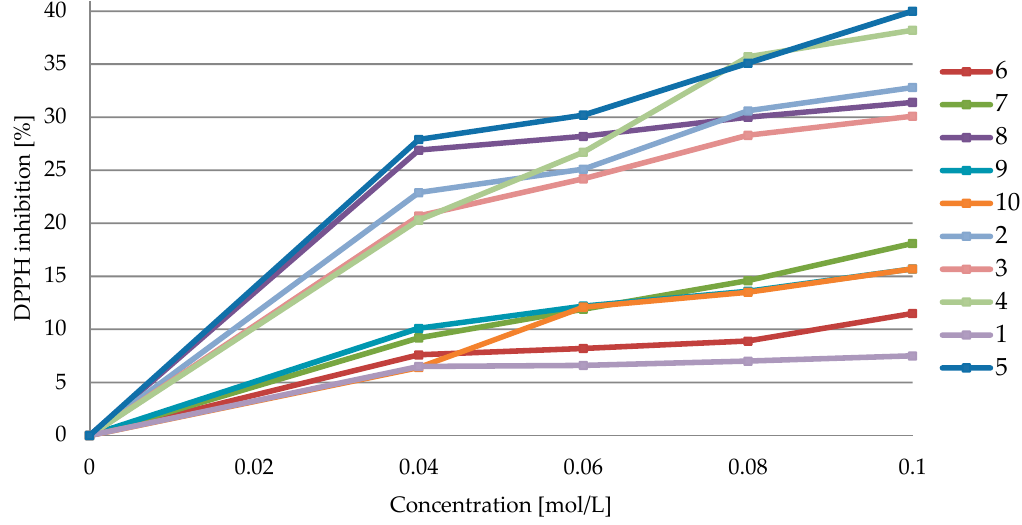
Figure 6. The radical scavenging activities for all complexes. Mefenamic acid (pale purple) is given as a reference. Table 6. The antibacterial and antifungal activities.